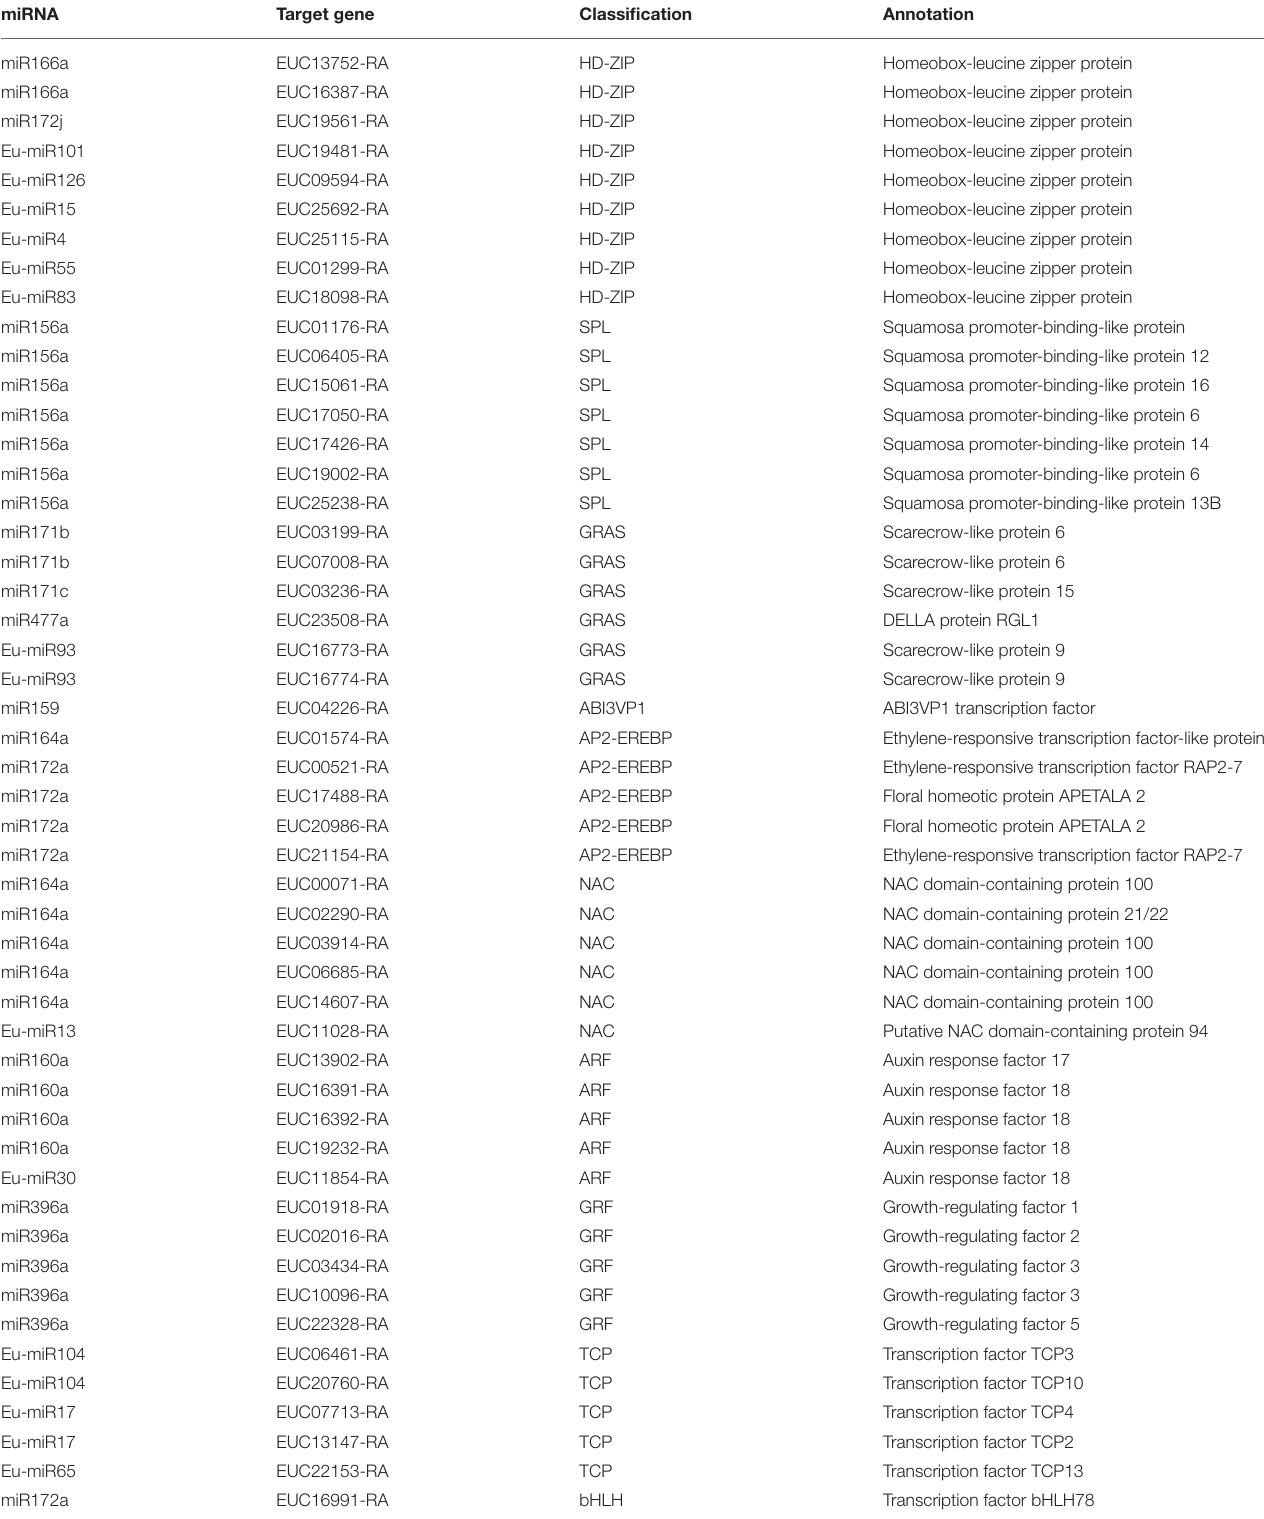
TABLE 3 | Identified candidate transcription factor targets of miRNAs in Eucommia